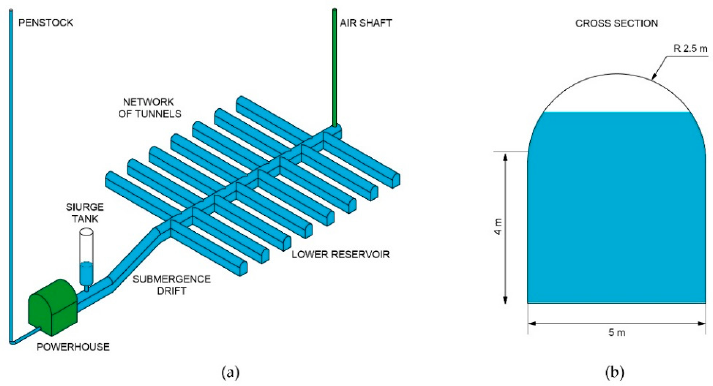
Figure 2. ( a ) Scheme of an UPSH plant with a lower water reservoir and an air shaft in a closed underground coal mine; ( b ) cross section of tunnels.